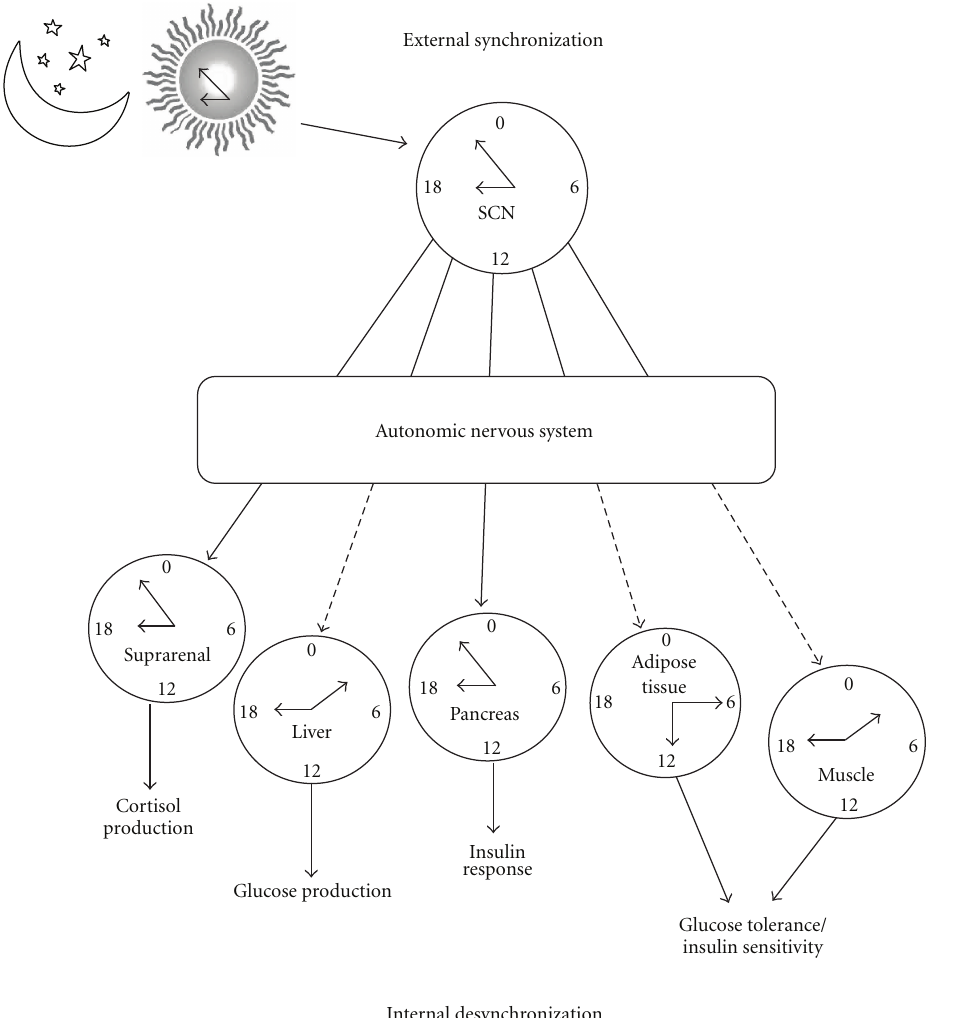
Figure 4: Schematic representation of a state of internal desynchronization. The biological clock (SCN) is synchronized with the dark- light cycle (external synchronization), and, in turn, the SCN synchronizes peripheral oscillators (internal synchronization). However, some oscillators may lose their synchronization with the SCN (dotted lines) due to alterations in the rhythmic output from the clock to the rest of the body or due to the interference given by nonphotic entraining stimuli, especially disturbed activity and feeding schedules. This uncoupling between the central clock and the peripheral oscillators is known as internal desynchronization, which results in physiological responses at the wrong time according to external requirements, which then leads to